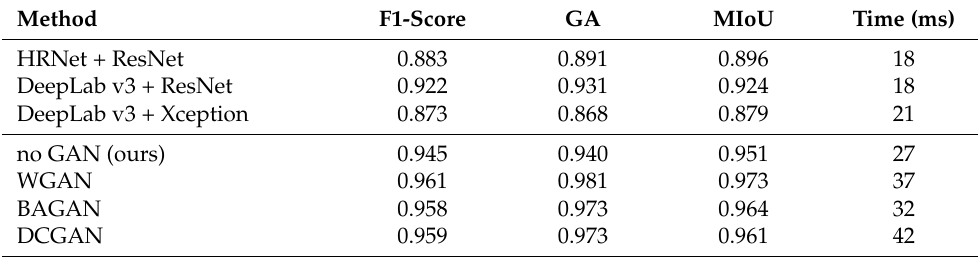
Table 3. Results of different implements of GAN